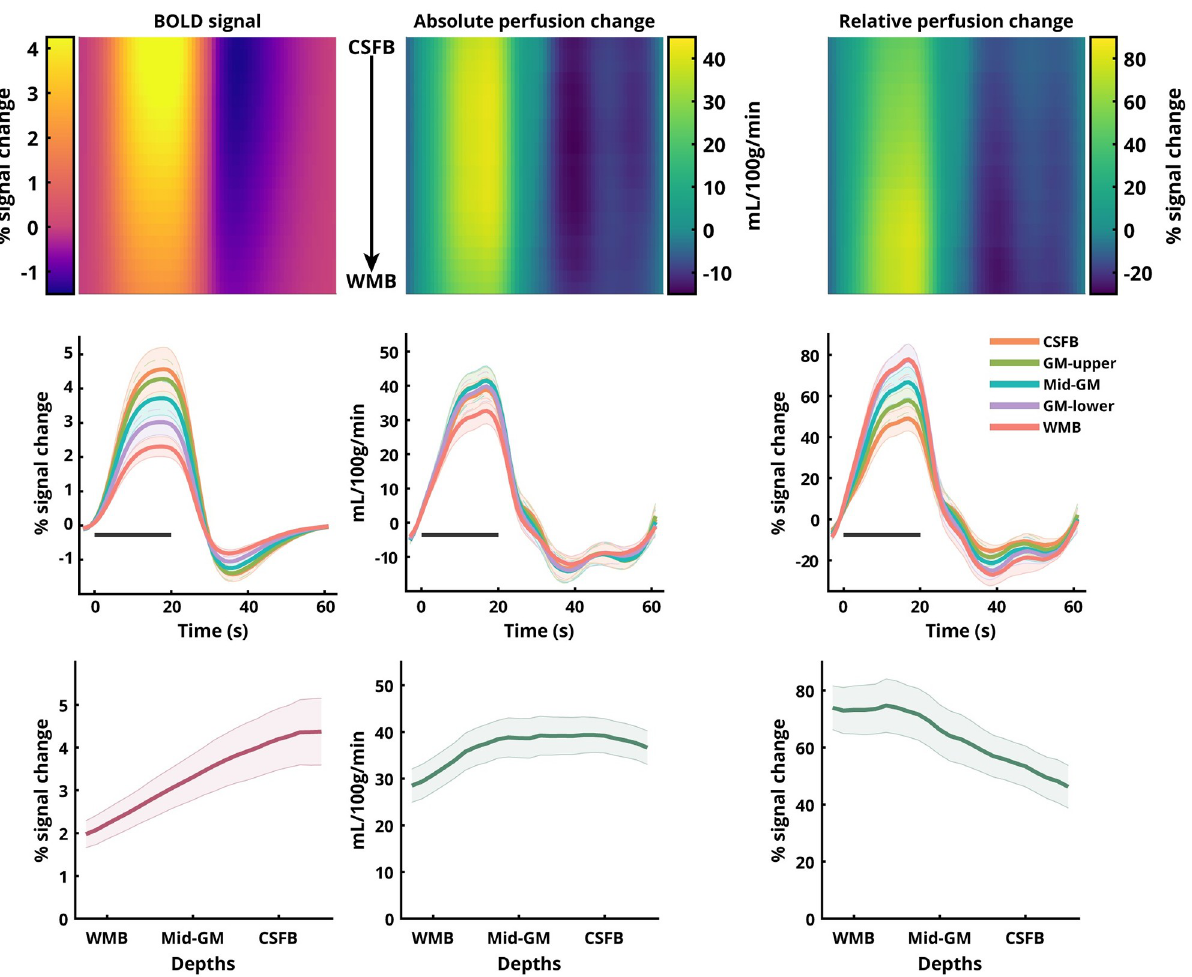
Fig 3. Laminar BOLD and perfusion signal changes in human V1 ROI obtained using sub-millimetre 3D-EPI ASL at 7 T. Top row: Heat-map representations of the group-average BOLD signal change, absolute perfusion change, and relative perfusion change with cortical depth along Y-axis and time along the X-axis. Middle row: Five out of the twenty-three total laminar time-courses for the respective sampled signals. Bottom row: Laminar profiles of the positive response during stimulation for the respective sampled signals with cortical depth along X-axis. Error-bars indicate SEM across participants. The black bar in the middle row indicates the stimulus